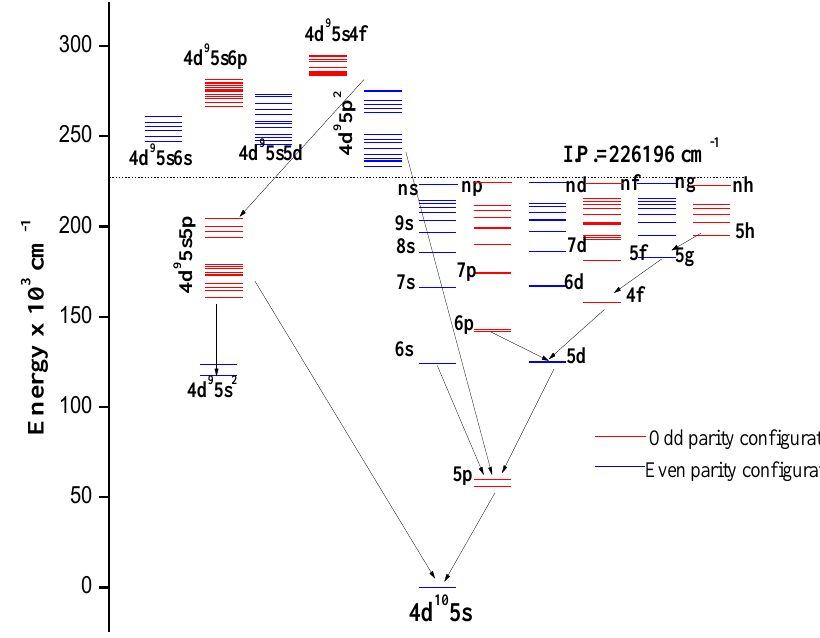
Figure 1. Grotrian diagram of In III. “I.P.” denotes the ionization potential (see Section 6). Arrows denote the observed transition arrays.